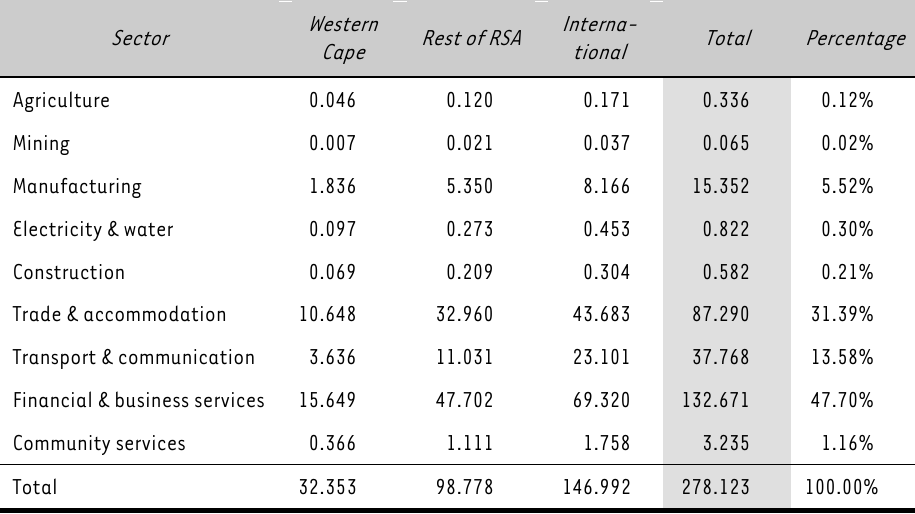
Western Interna- Rest of RSA Total Percentage Cape tional